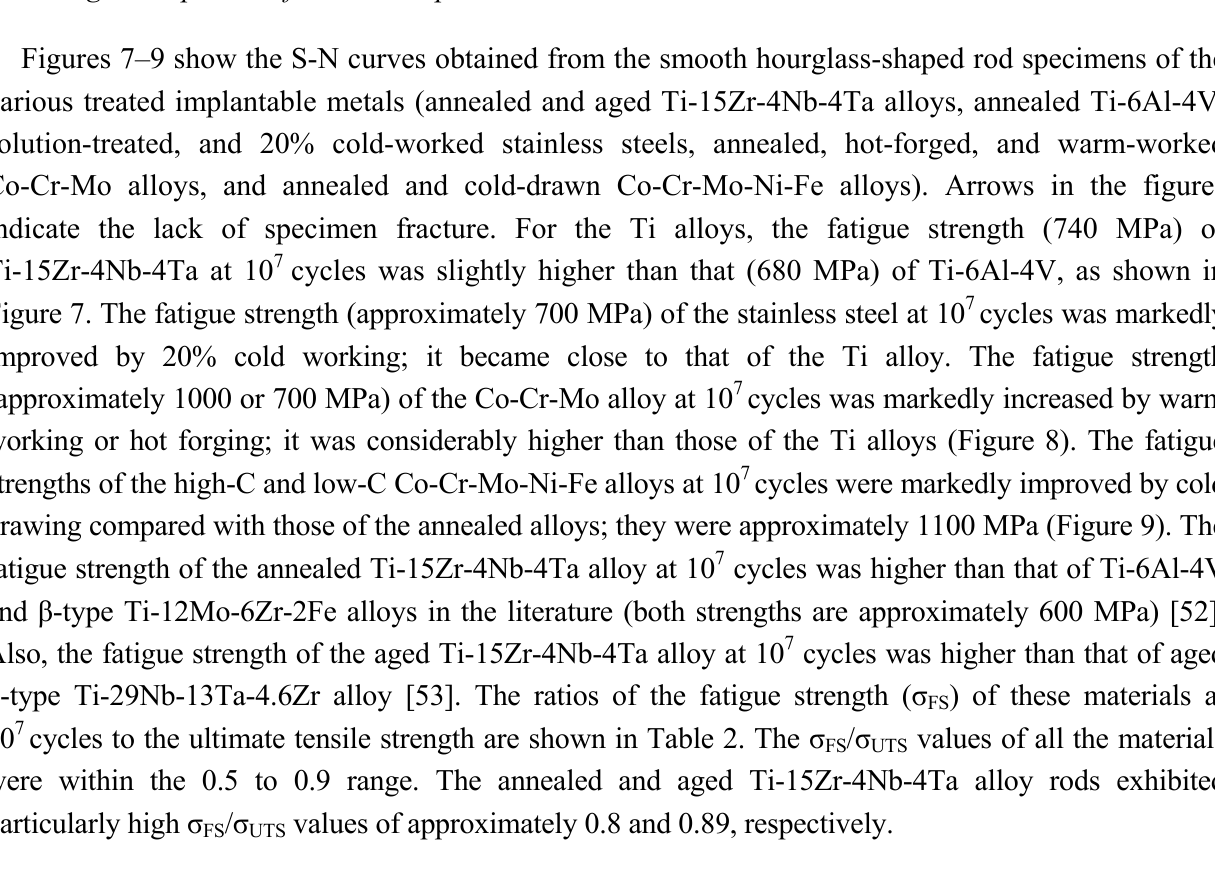
Figure 7. S-N curves obtained by tension-to-tension fatigue test in air for ( a ) annealed and aged Ti-15Zr-4Nb-4Ta alloys; and ( b ) annealed Ti-6Al-4V alloy